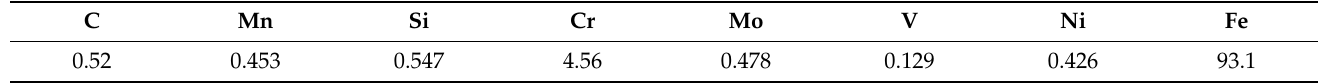
Table 1. Chemical compositions of Cr5 steel in